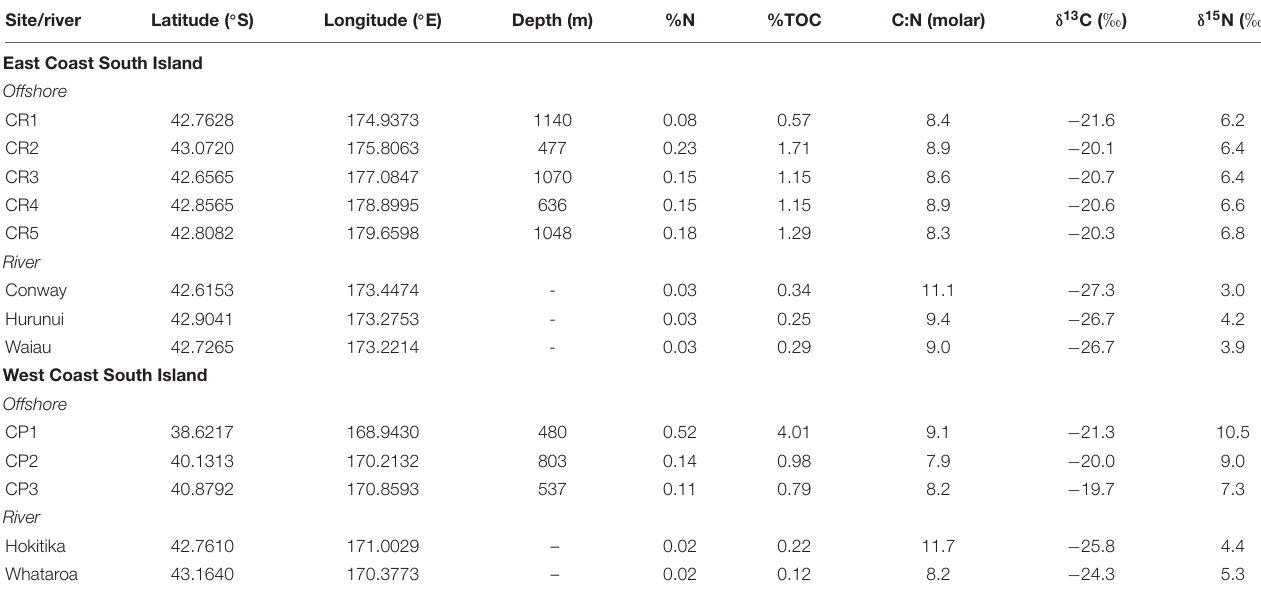
TABLE 2 | Summary of offshore and river mouth sampling